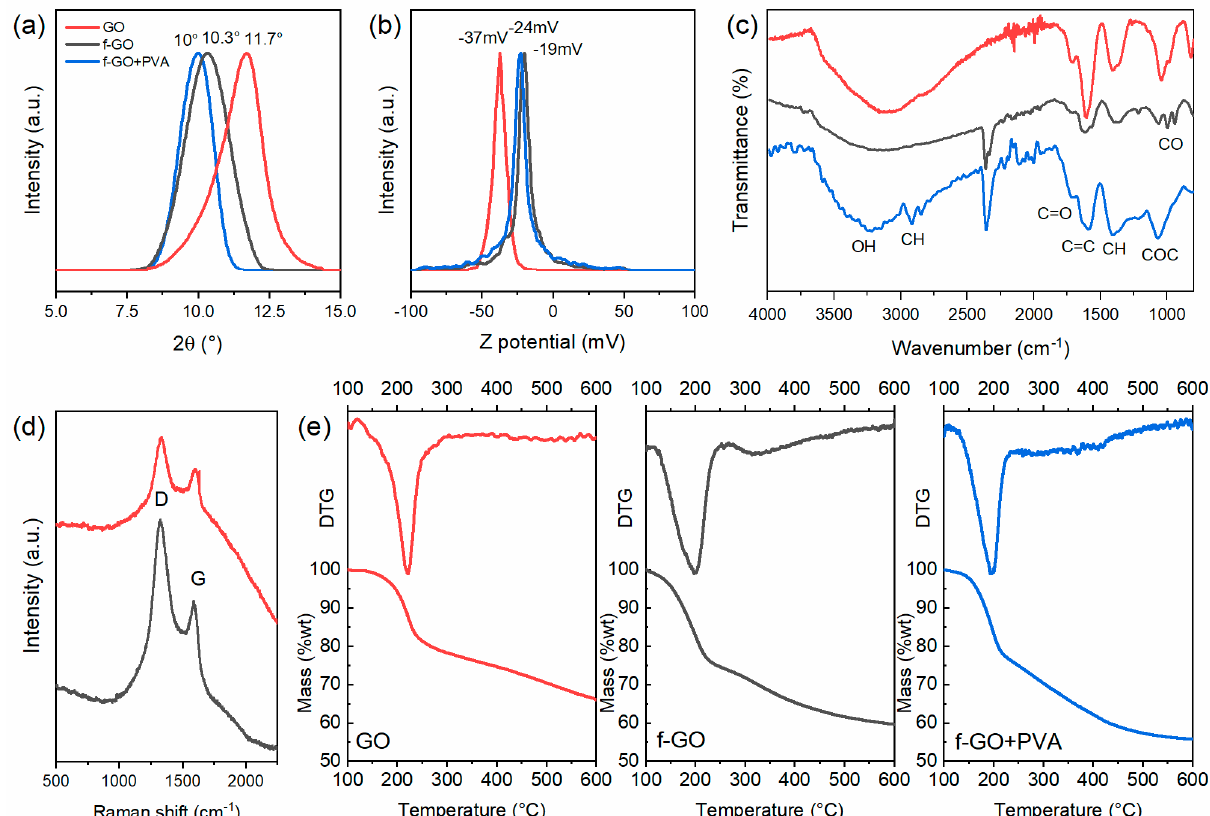
Figure 3. Characterizations of the three different membranes where the pristine GO is the red line, the f-GO is the black line, and the nanocomposite is the blue line. ( a ) XRD patterns of the three membranes prior to the filtrations. ( b ) Z-potential measurements of the aqueous solutions. ( c ) FTIR spectra, ( d ) Raman spectra, and ( e ) TGA and DTG of the three membranes.